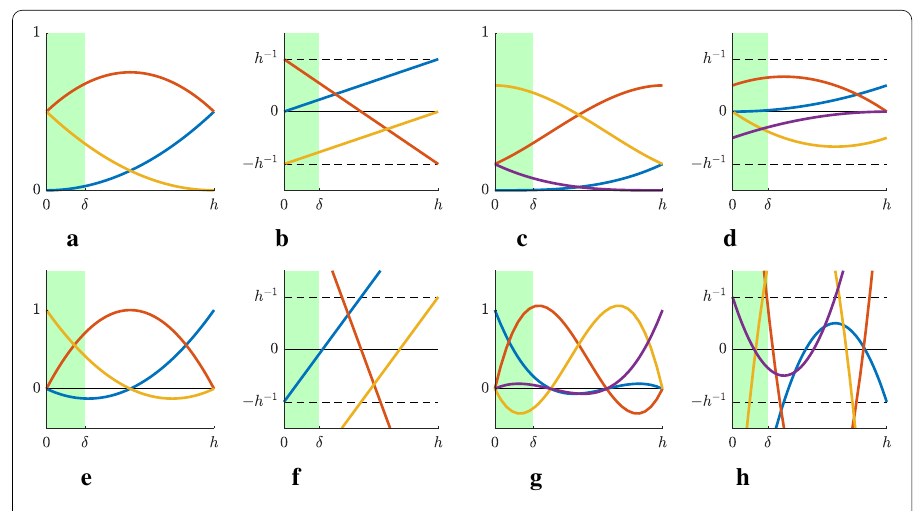
Fig. 2 B-spline (top row) and Lagrange (bottom row) basis functions of order p = 2 , 3 in a 1D element intersecting (cid:3) . Note that gradient of the blue B-spline basis functions is O ( h − 1 ( δ h ) p − 1 ) within (cid:3) while the gradient of Lagrange basis functions is O ( h − 1 ) regardless of p . a C 1 Q 2 basis. b C 1 Q 2 gradient. c C 2 Q 3 basis. d C 2 Q